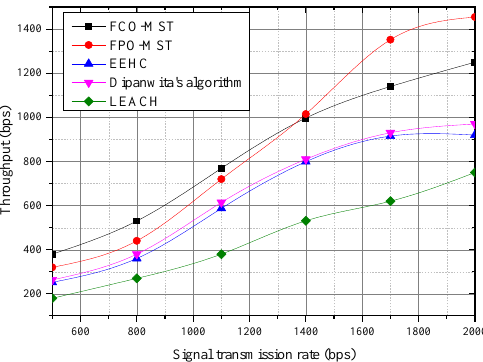
Figure 13. The comparison of throughput under different transmission rates.